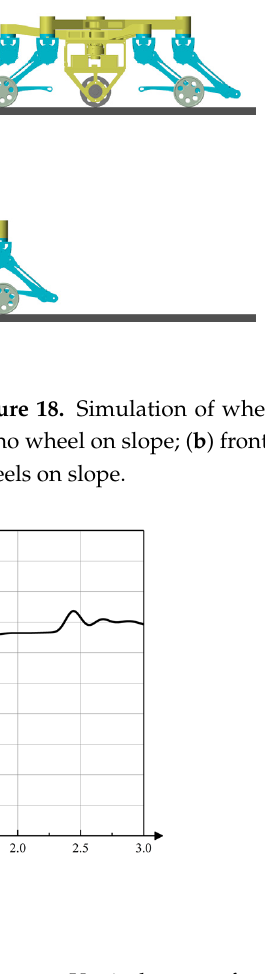
Figure 19. Vertical contact force between wheels and ground (unilateral passive wheels and active